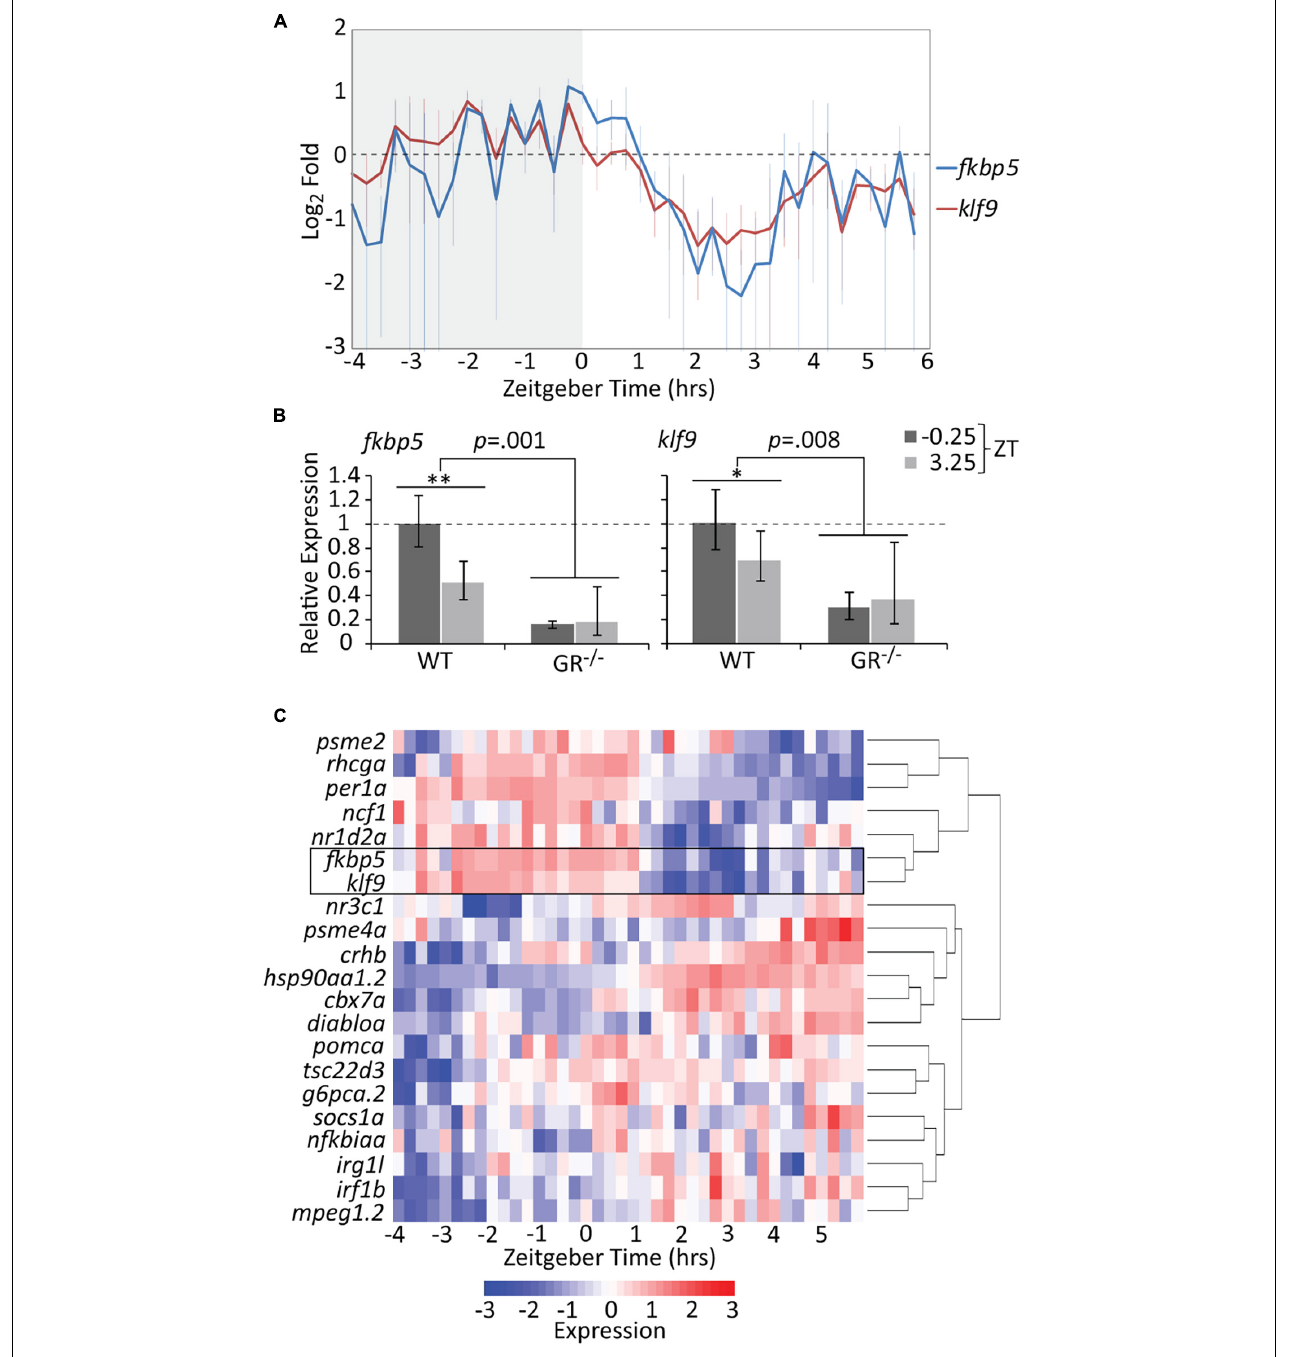
FIGURE 1 | The temporal activities of the GR targets klf9 and fkbp5 are dynamic and synchronous. (A) Average relative levels of klf9 and fkbp5 transcripts in three biological replicates of pooled ( n = 3–6) 5 dpf larvae snap-frozen every 15 min from − 4 to 6 h zeitgeber time (ZT). Error bars are standard error of the mean of three biological replicates. (B) Relative expression of klf9 and fkbp5 in WT and nr3c1 − / − (GR 369 − , Gans et al., 2020) mutant larvae at − 0.25 and +3.25 ZT, time points that, respectively, correspond to the activity peak and nadir of both genes in WT larvae. Error bars represent 95% confidence intervals of three biological replicates of pooled larvae ( n = 9 per sample). Significance calculated by two-factor (time and genotype) ANOVA, and one-tailed t -tests to assess the effect of time within each genotype; ∗∗ p = 0.01; ∗ p = 0.05. (C) Heat map of expression of klf9 , fkbp5 , and additional targets/regulators of glucocorticoid (GC) signaling as measured on the NanoString platform. Gene panel includes well-known glucocorticoid receptor (GR) targets as well as targets identified by our lab as consistently over-expressed in chronic CORT treated (Gans et al., 2020). Counts data are normalized to reference genes ( actb2 , rpl13a , and eif5a ) and scaled within each gene to normalize for different absolute levels of